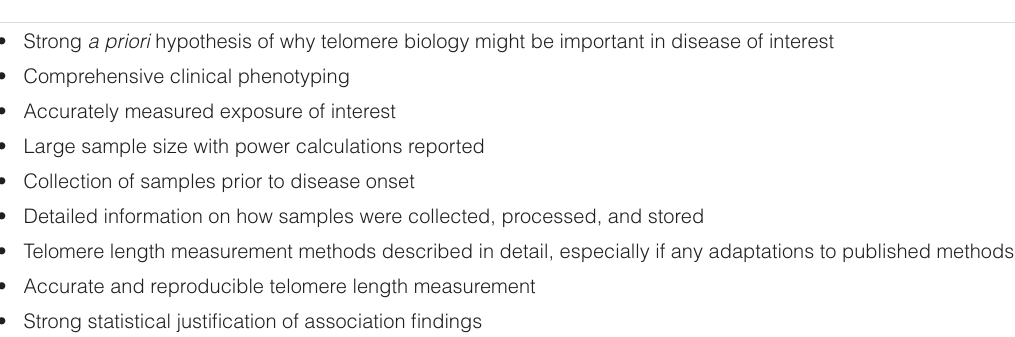
Table 3. Features of robust telomere length association